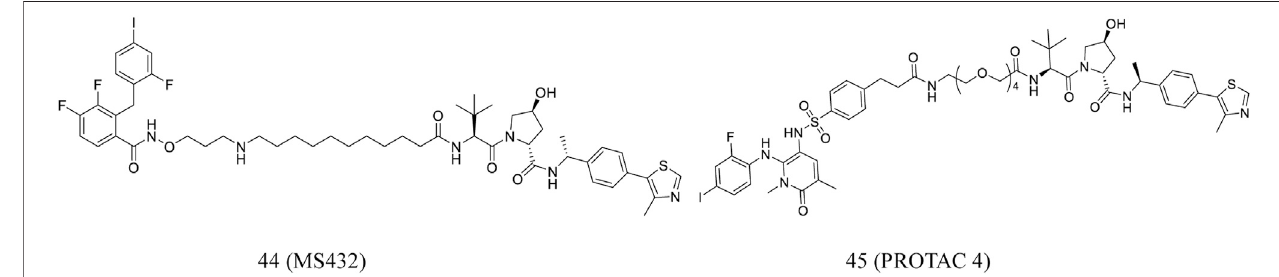
FIGURE 8 | Chemical structures of PROTACs targeting